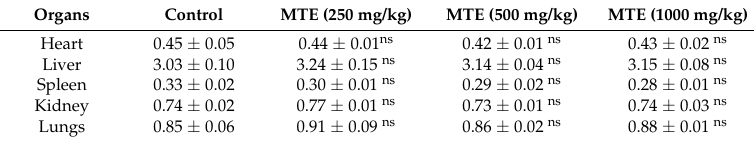
Table 5. The relative organ weight of rats treated with different doses of MTE for 28 days.